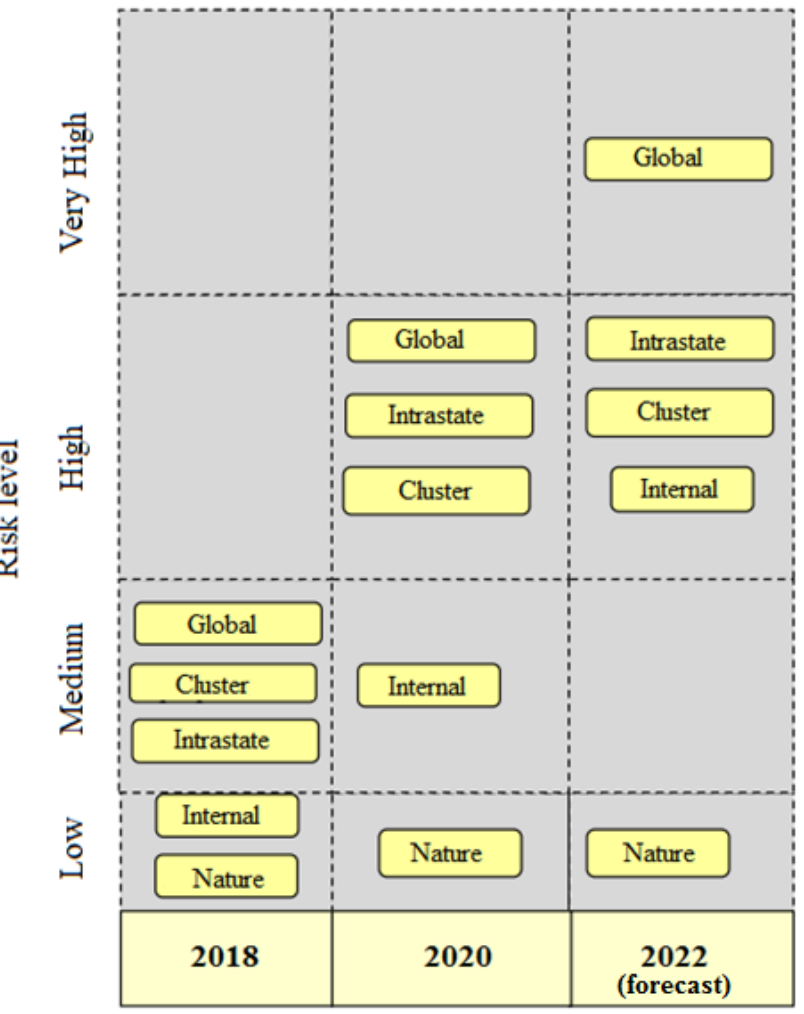
Figure 9. Dynamics of aggregated risk groups of cluster enterprises. Developed by Izmalkova I.